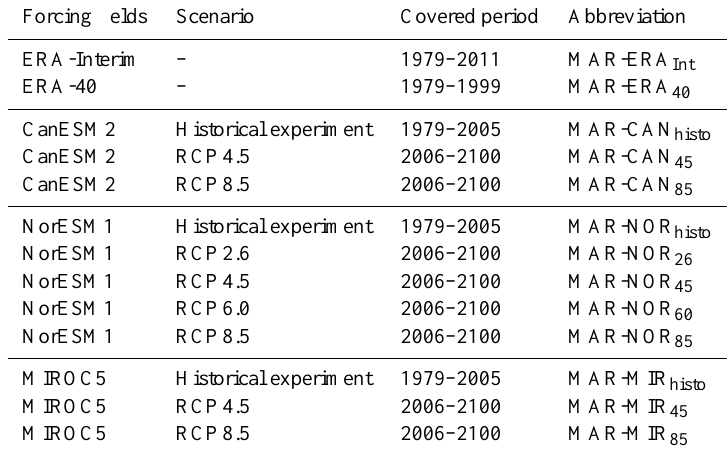
Table 1. Forcing fields used to perform MAR simulations, scenario, covered period, and abbreviation of the